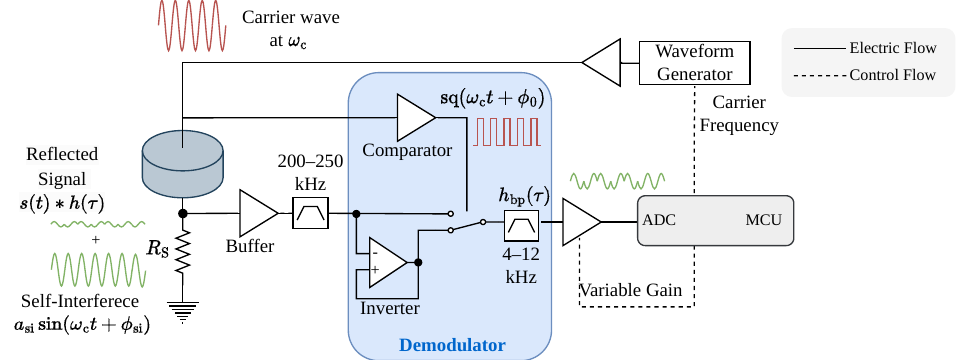
Figure 6. The signal is filtered and demodulated in hardware to remove the carrier frequency at the reader. Afterward, a bandpass filter removes the self-interference, only leaving the backscattered signal.